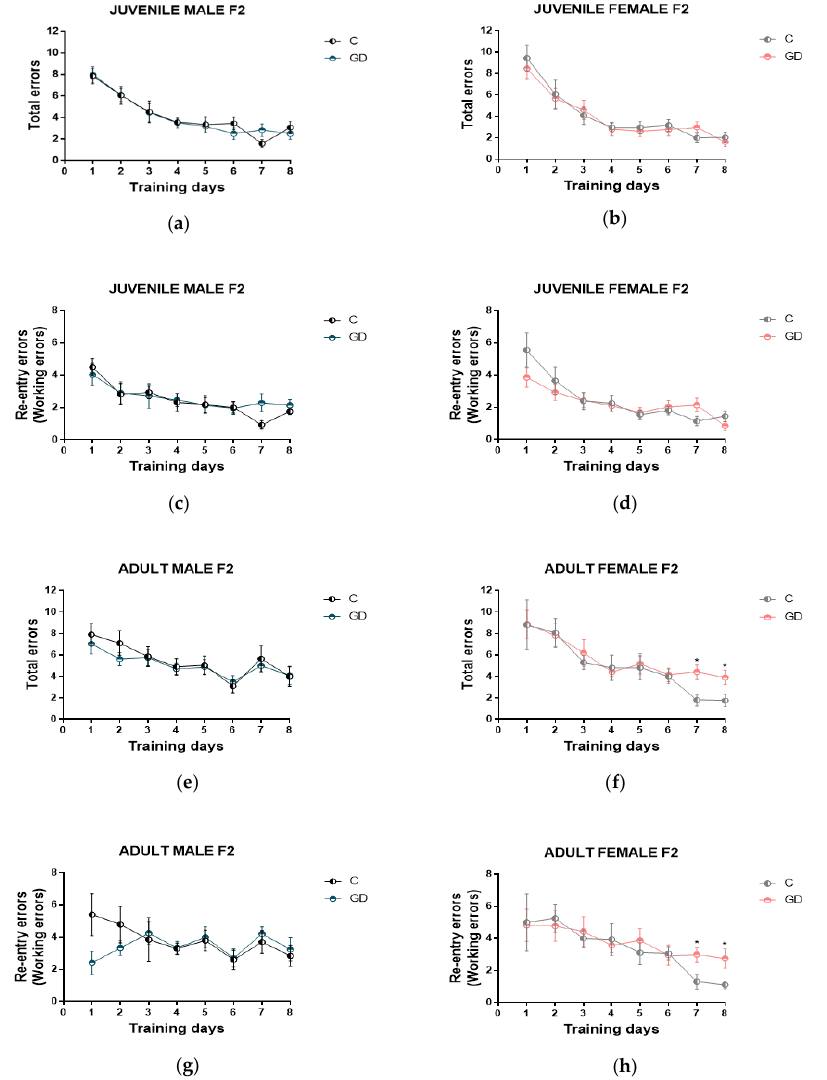
Figure 3. Effect of GD on the spatial working memory of second-generation offspring. The number of errors throughout the trial days can be seen. The total and re-entry errors ( a – d ) of the male and female offspring of juvenile and adult age ( e – h ) are shown. C, offspring of control rats; GD, offspring of rats with gestational diabetes, n = 10 to 12. The data are expressed as the mean ± SEM. Two-way repeated-measures ANOVA, one-way ANOVA; Tukey’s post hoc, Student’s t -test, * p < 0.05.